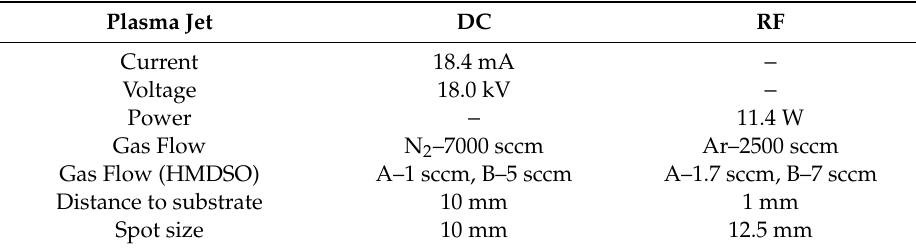
Table A1. Experimental conditions for DC and RF plasma jets.